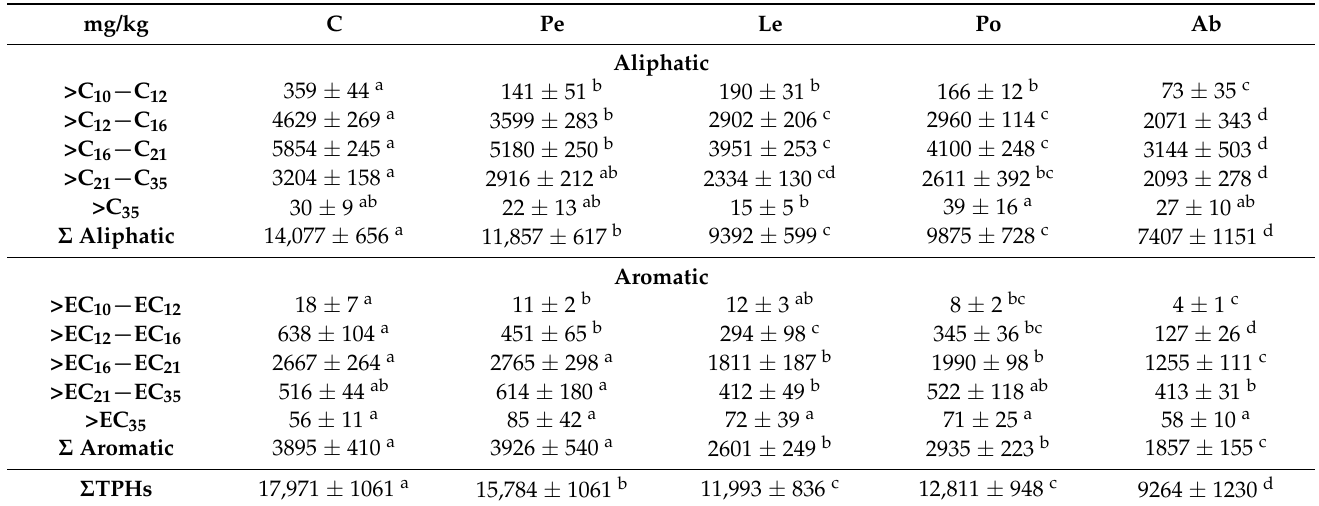
Table 3. Concentration of TPHs and aliphatic and aromatic fractions by chains (mean ± standard deviation) of the control microcosms (C), and microcosms inoculated with SMS of P. eryngii (Pe), L. edodes (Le), P. ostreatus (Po) and A. bisporus (Ab) at the end of the incubation. Data is presented as mean values ± standard deviation ( n = 3). The same letters indicate a lack of statistically significant difference ( p < 0.05) between